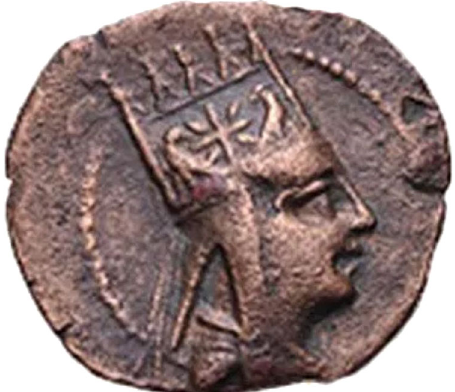
Fig. 4 Coin of King Antiochus I. King Antiochus with Regulus on tiara fl anked by two eagles. Alram, M. Nomina Propria Iranica in Nummis (1986), p 240. This fi gure is not covered by the Creative Commons Attribution 4.0